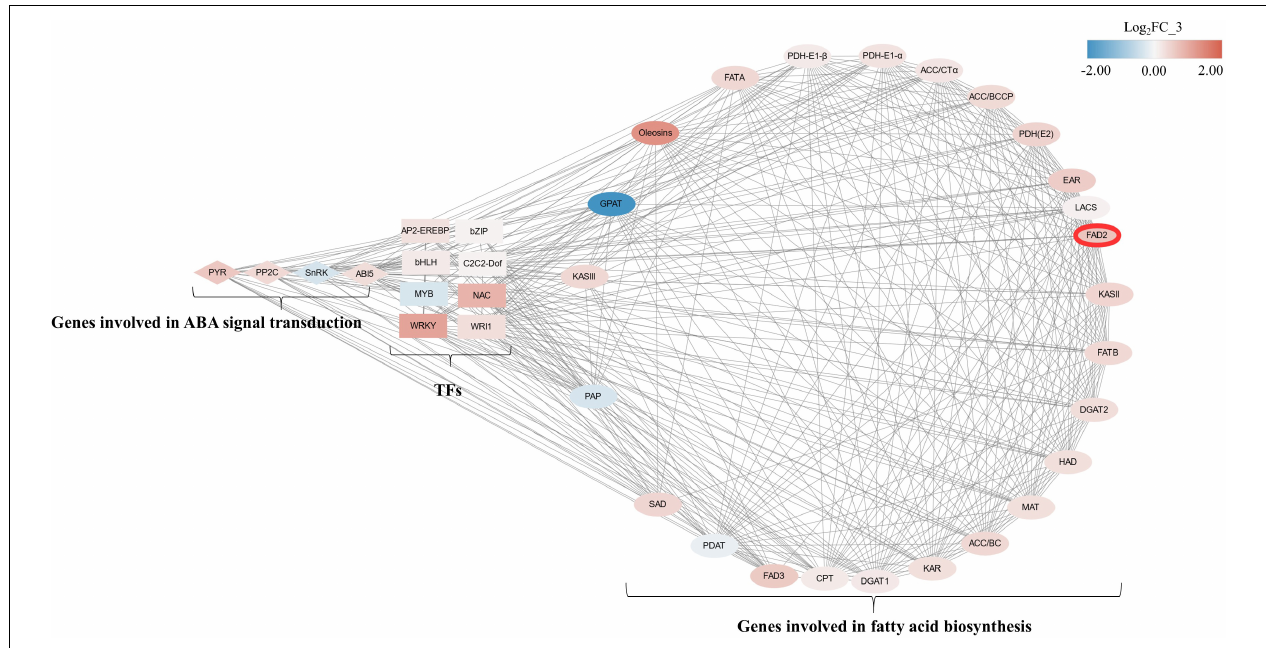
FIGURE 7 | Correlation network of genes involving fatty acid biosynthesis, ABA-signaling transduction, and transcriptional factors between CK and A2 during mesocarp development. Ellipses, diamonds, and rectangles, respectively, represent genes involving fatty acid biosynthesis, ABA-signaling transduction, and transcriptional factors. Node fill color is according to log 2 FC of FPKM value in CK_3 vs. A2_3 from blue to red; TFs, transcriptional factors; PYR, pyrabactin resistance; PP2C, type 2C protein phosphatases; SnRK, Snf1-related protein kinase; ABI5, ABA insensitive 5; AP2-EREBP, APETALA2-ethylene responsive element-binding protein; bZIP, basic leucine zipper; bHLH, basic helix loop helix; C2C2-Dof, downstream of FGFR; MYB, myeloblastosis; NAC, nascent polypeptide-associated complex; WRKY, WRKY transcriptional factor; WRI1, WRINKLED1; KASIII, 3-ketoacyl-ACP synthase III; GPAT,